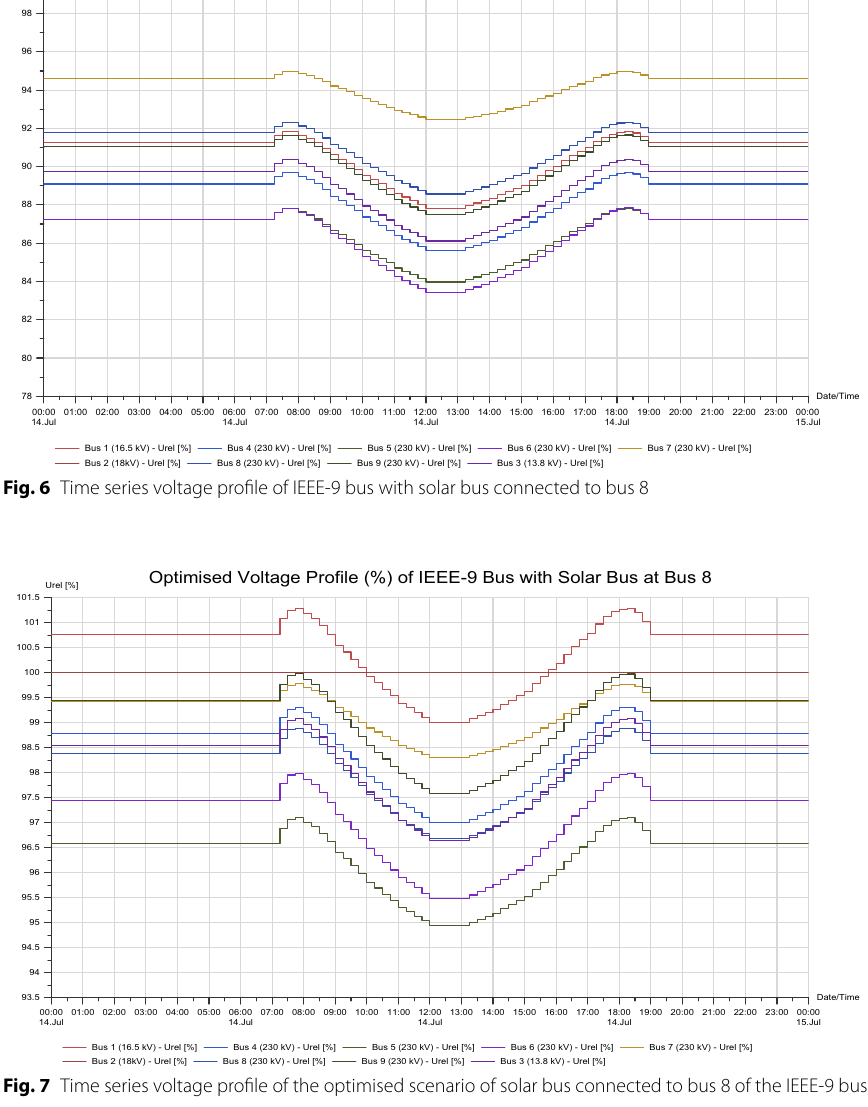
Voltage Profile (%) of IEEE-9 Bus with Solar Bus at Bus 8